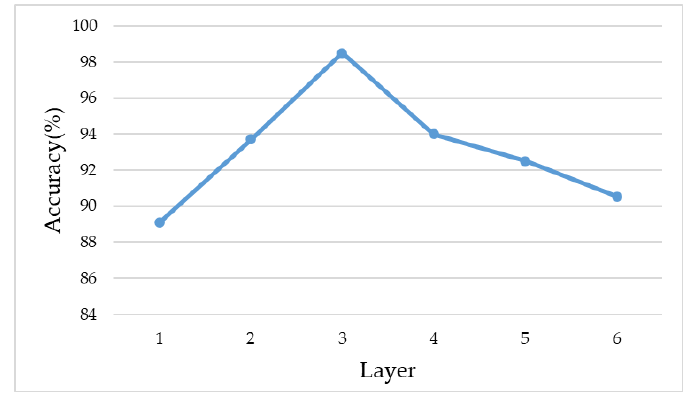
Figure 6. Accuracies with various layer numbers. Table 1. Normalized Hamming distances between the segmented images under di ff erent illuminations. Illumination Scale